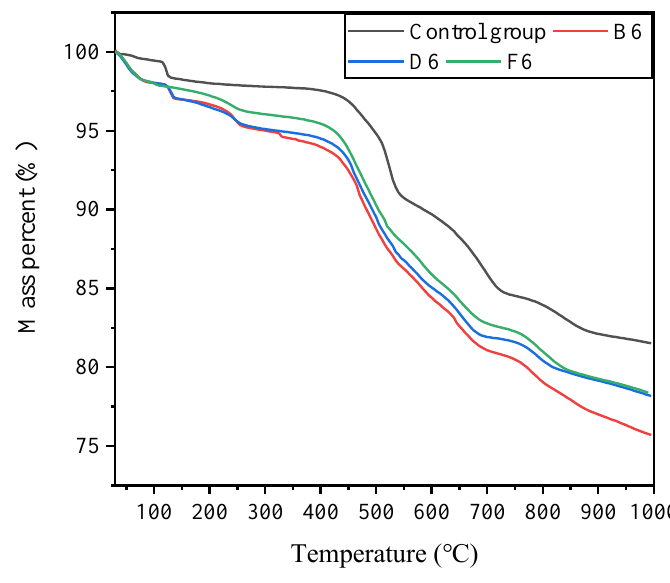
Figure 9. The results of TG.